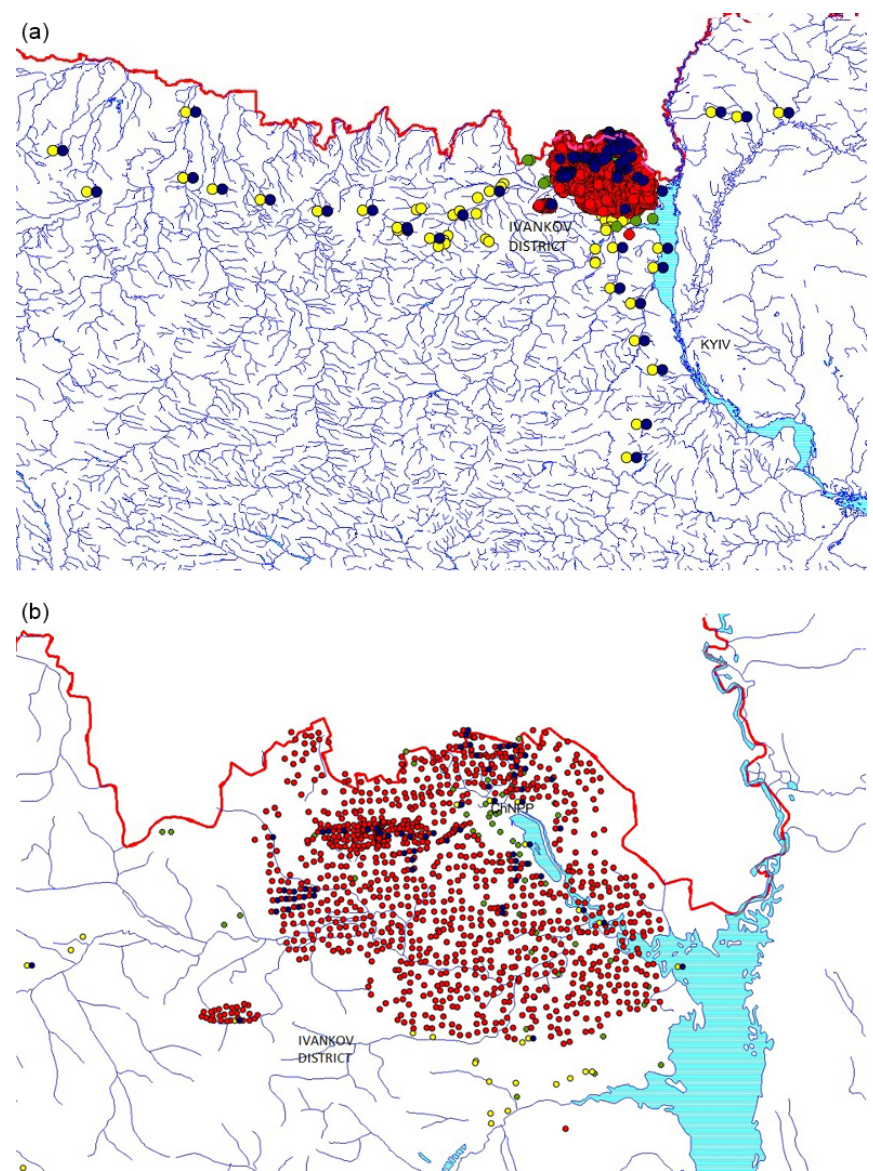
Figure 2. Sampling locations for the different studies in the CEZ (red – (1) spatial dataset of radiocaesium, 90 Sr and soil chemistry parame- ters; dark blue – (2) Pu isotope measurements in bulk soil samples; yellow – (3) Pu isotope measurements in sectioned soil samples; green – (5) fuel particle dissolution dataset; (6) Ivankov district (sampling locations see Fig.